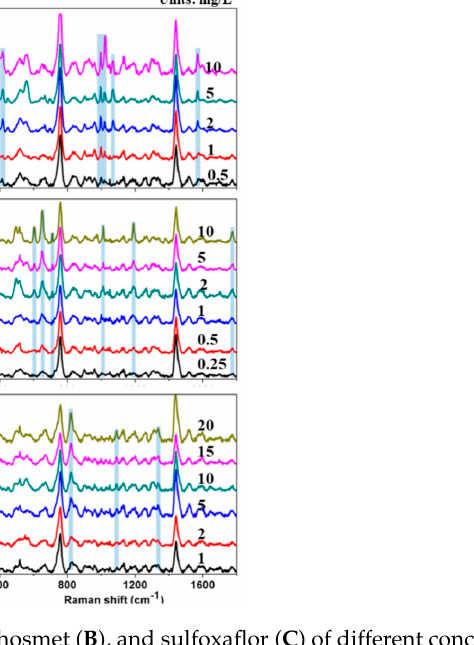
Figure 3. SERS spectra of fonofos ( A ), phosmet ( B ), and sulfoxaflor ( C ) of different concentrations in paddy